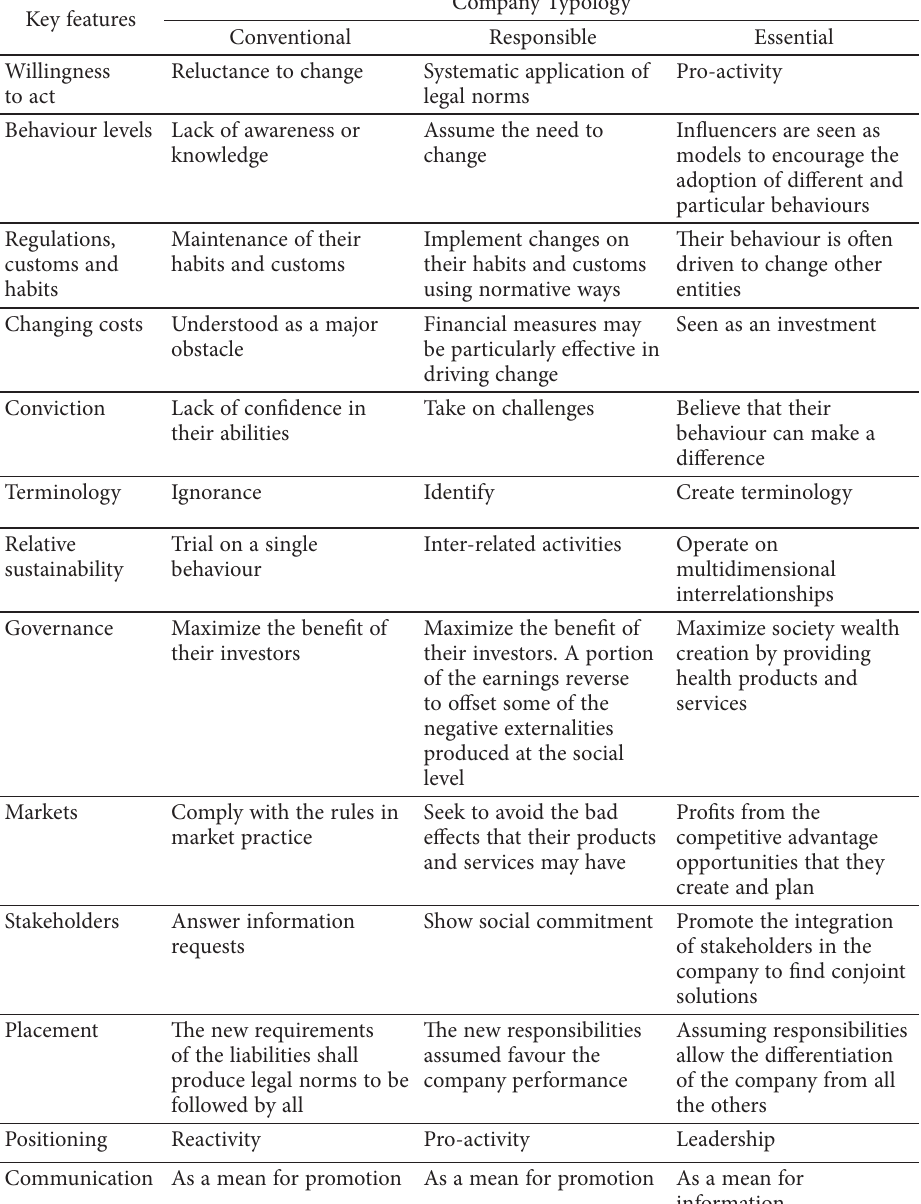
Table 3. Key features for the characterization on company